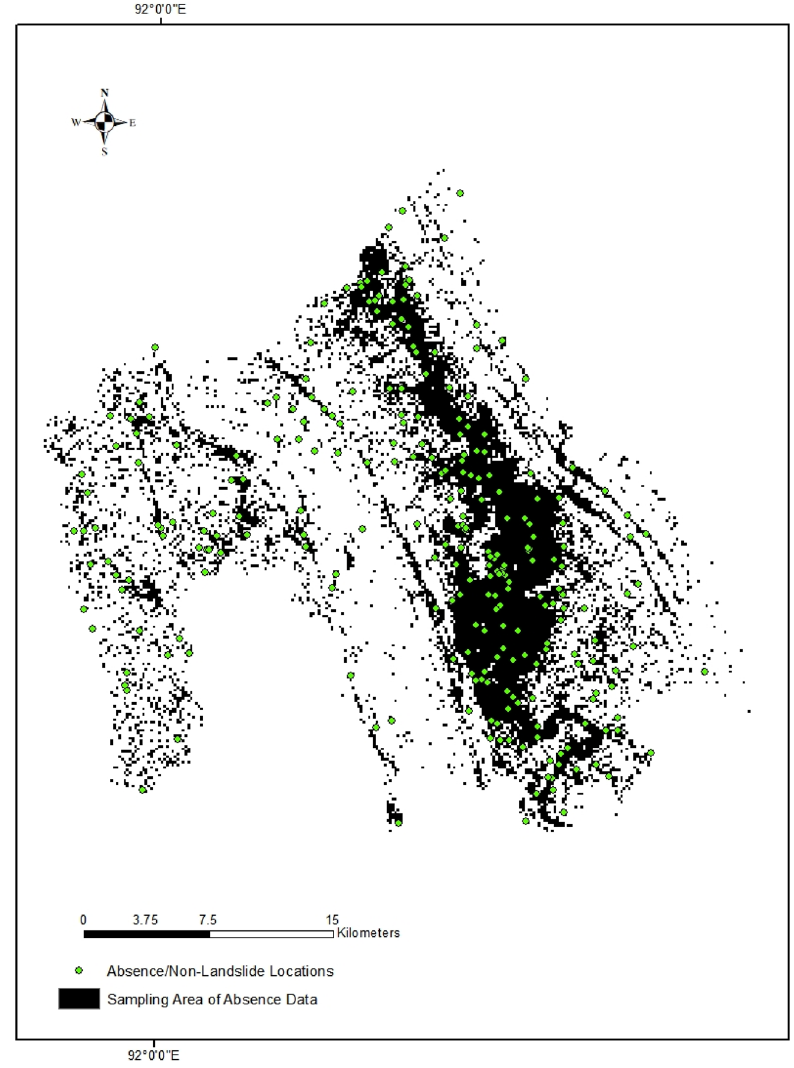
Figure 7. Absence-data sampling area based on different thresholds of slope (Maps were produced using ArcMap